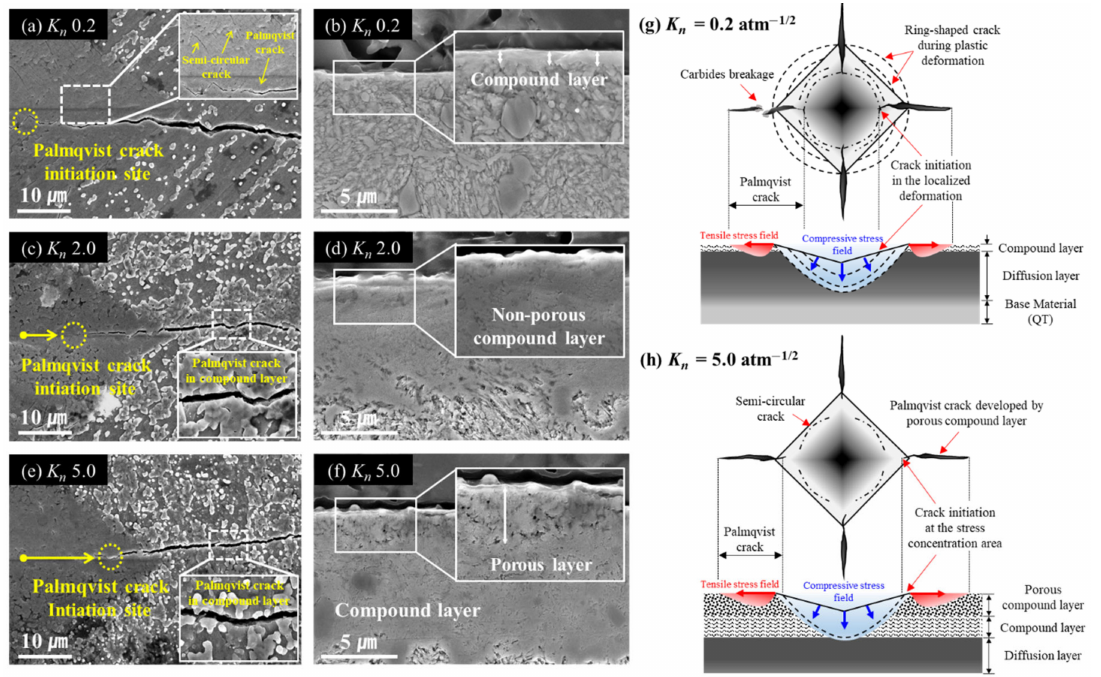
Figure 9. SEM images showing the locations of initial Palmqvist cracks on the nitrided surface ( a , c , e ) corresponding to the cross-sectional microstructures of compound layers ( b , d , f ), and schematic diagrams of crack patterns near the nitrided surface showing the different crack growth behaviors at K n = ( g ) 0.2, and ( h ) 5.0 atm − 1/2 .